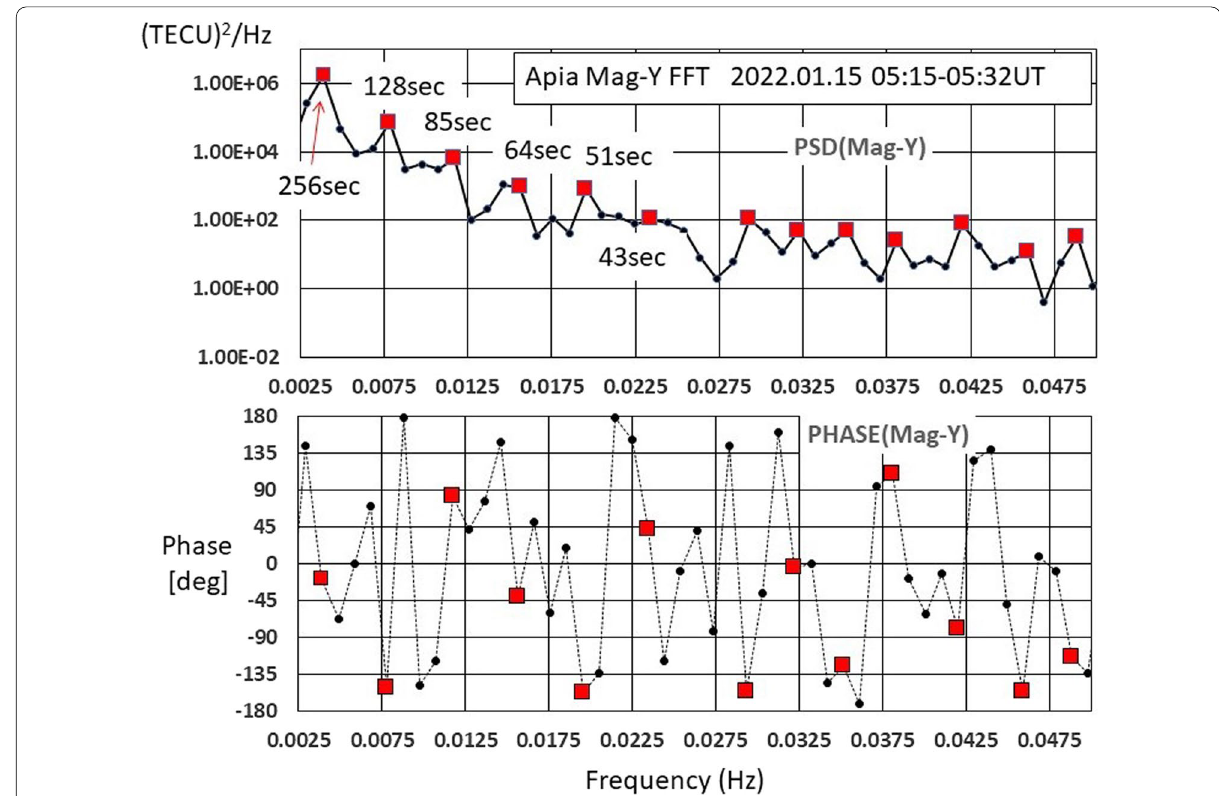
Fig. 12 Harmonic structure of the PSD in 05:15–05:32 UT when a sawtooth waveform is observed (upper panel). Higher harmonics of the fundamental period around 265 s (256 s in this plot because of FFT algorism) is seen. The lower panel shows the phase of each frequency